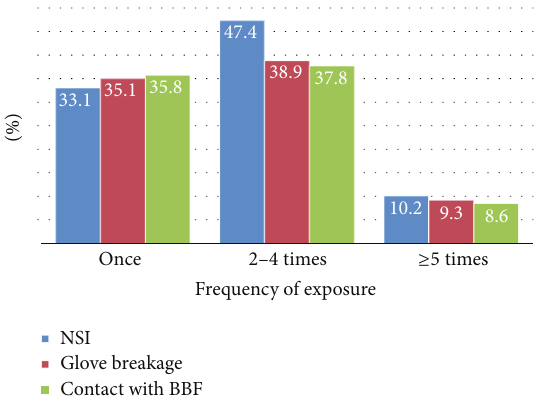
Figure 4: Needle stick injury (NSI), glove breakage, and contact with potentially infectious blood and other body fluids versus frequency of exposure among healthcare workers in Debre Berhan town, 2014.